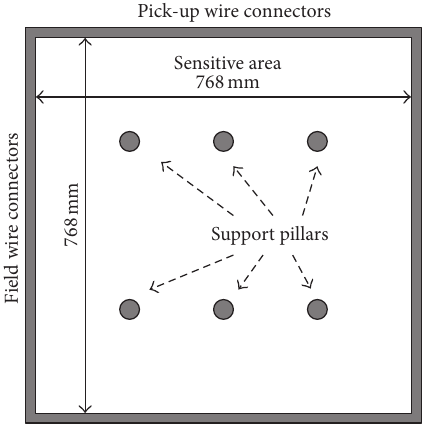
Figure 2: Schematic representation of the detector sensitive area. Field and pick-up wire connectors cover one side each. The approxi- mate positions of the internal support pillars (in our case 6 of them) are also indicated (not to